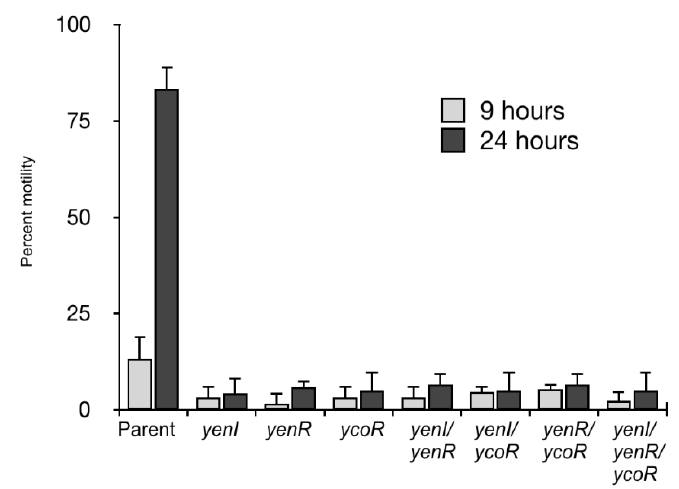
Figure 3. Swimming motility in liquid culture. After 9 h and 24 h, the parent population was substantially more motile than the quorum sensing (QS) mutants, with a particularly marked difference after 24 h.